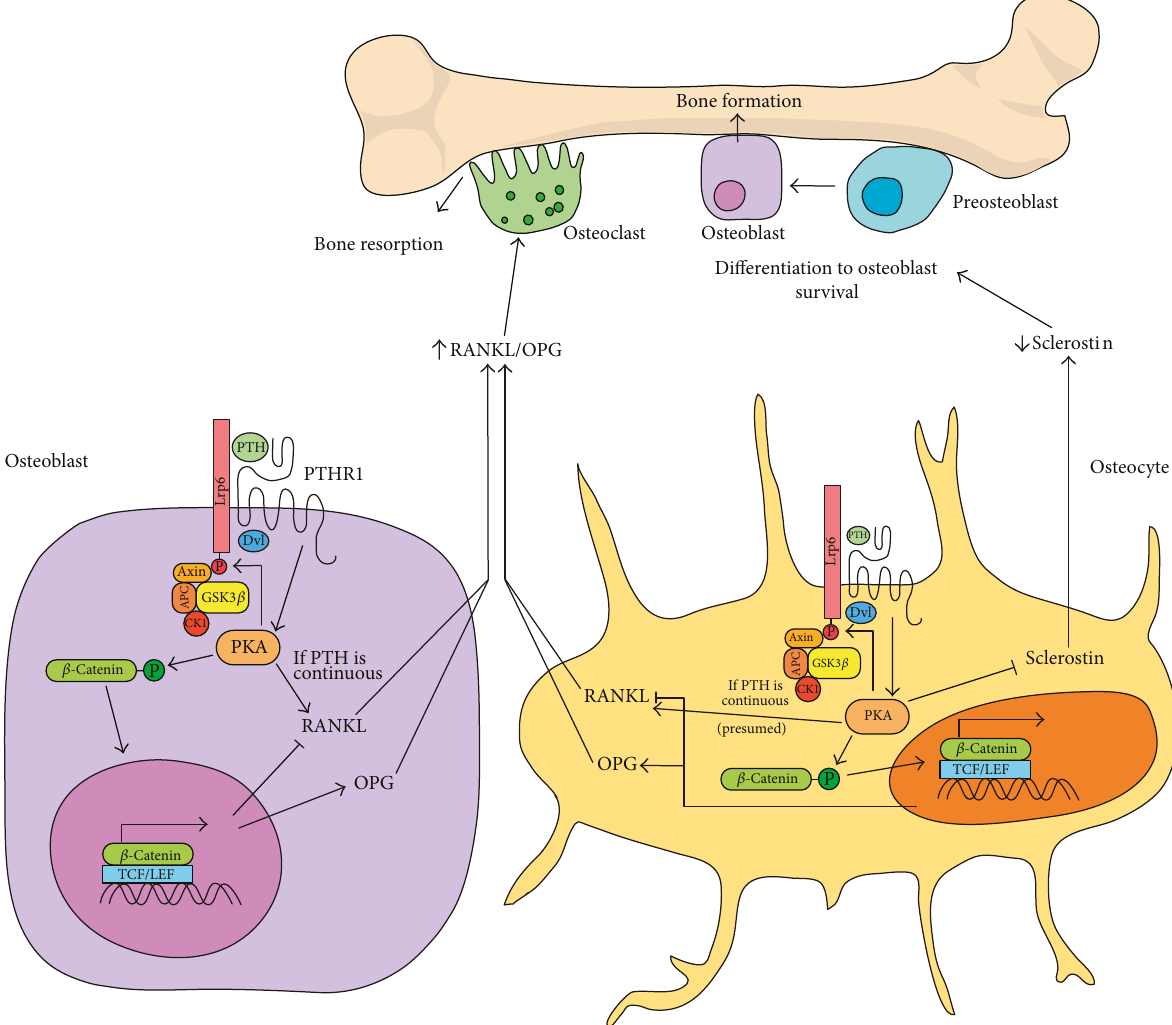
Figure 3: Proposed mechanisms by which PTH activates Wnt/ β -catenin pathway in osteoblasts and osteocytes to modulate bone turnover. In the osteoblast (left), PTH binding to Lrp6 and PTH1R activates PKA, which activates the Wnt/ β -catenin pathway by phosphorylating Lrp6. The levels of β -catenin rise, which leads to modulation of RANKL and OPG expression resulting in a decreased RANKL/OPG ratio. PKA itself can also directly stabilize β -catenin through phosphorylation and also directly stimulates RANKL production. The increased production of RANKL when PTH is administered continuously might be mediated by this action of PKA. A similar mechanism occurs in the osteocyte (right), presumably also through Lrp6 signaling. While it is uncon fi rmed whether PKA can also directly stimulate RANKL transcription in osteocytes, continuous PTH in osteocytes activates RANKL production while only activating the Wnt/ β -catenin instead increases OPG production. A notable di ff erence between how both cell types respond to PTH is that PKA activation inhibits sclerostin production in osteocytes. The decrease in sclerostin could partly explain the resulting increase in bone formation when PTH is given intermittently. Moreover, expression of sclerostin in osteocytes seems to further upregulate RANKL in those same